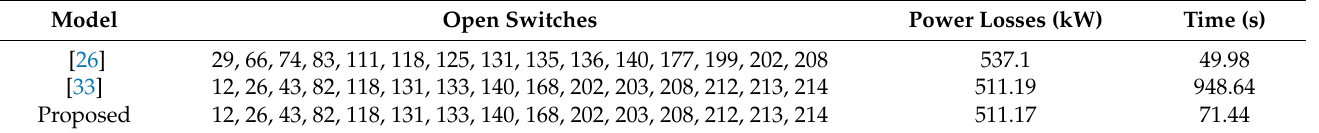
Table 16. Comparative analysis of the 202-bus test